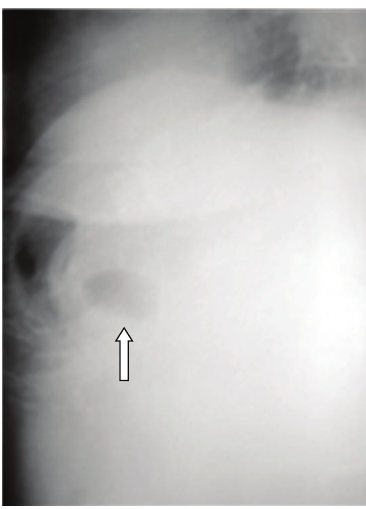
Figure 1: A plain abdominal X-ray suspecting the presence of air in the gallbladder (arrow).